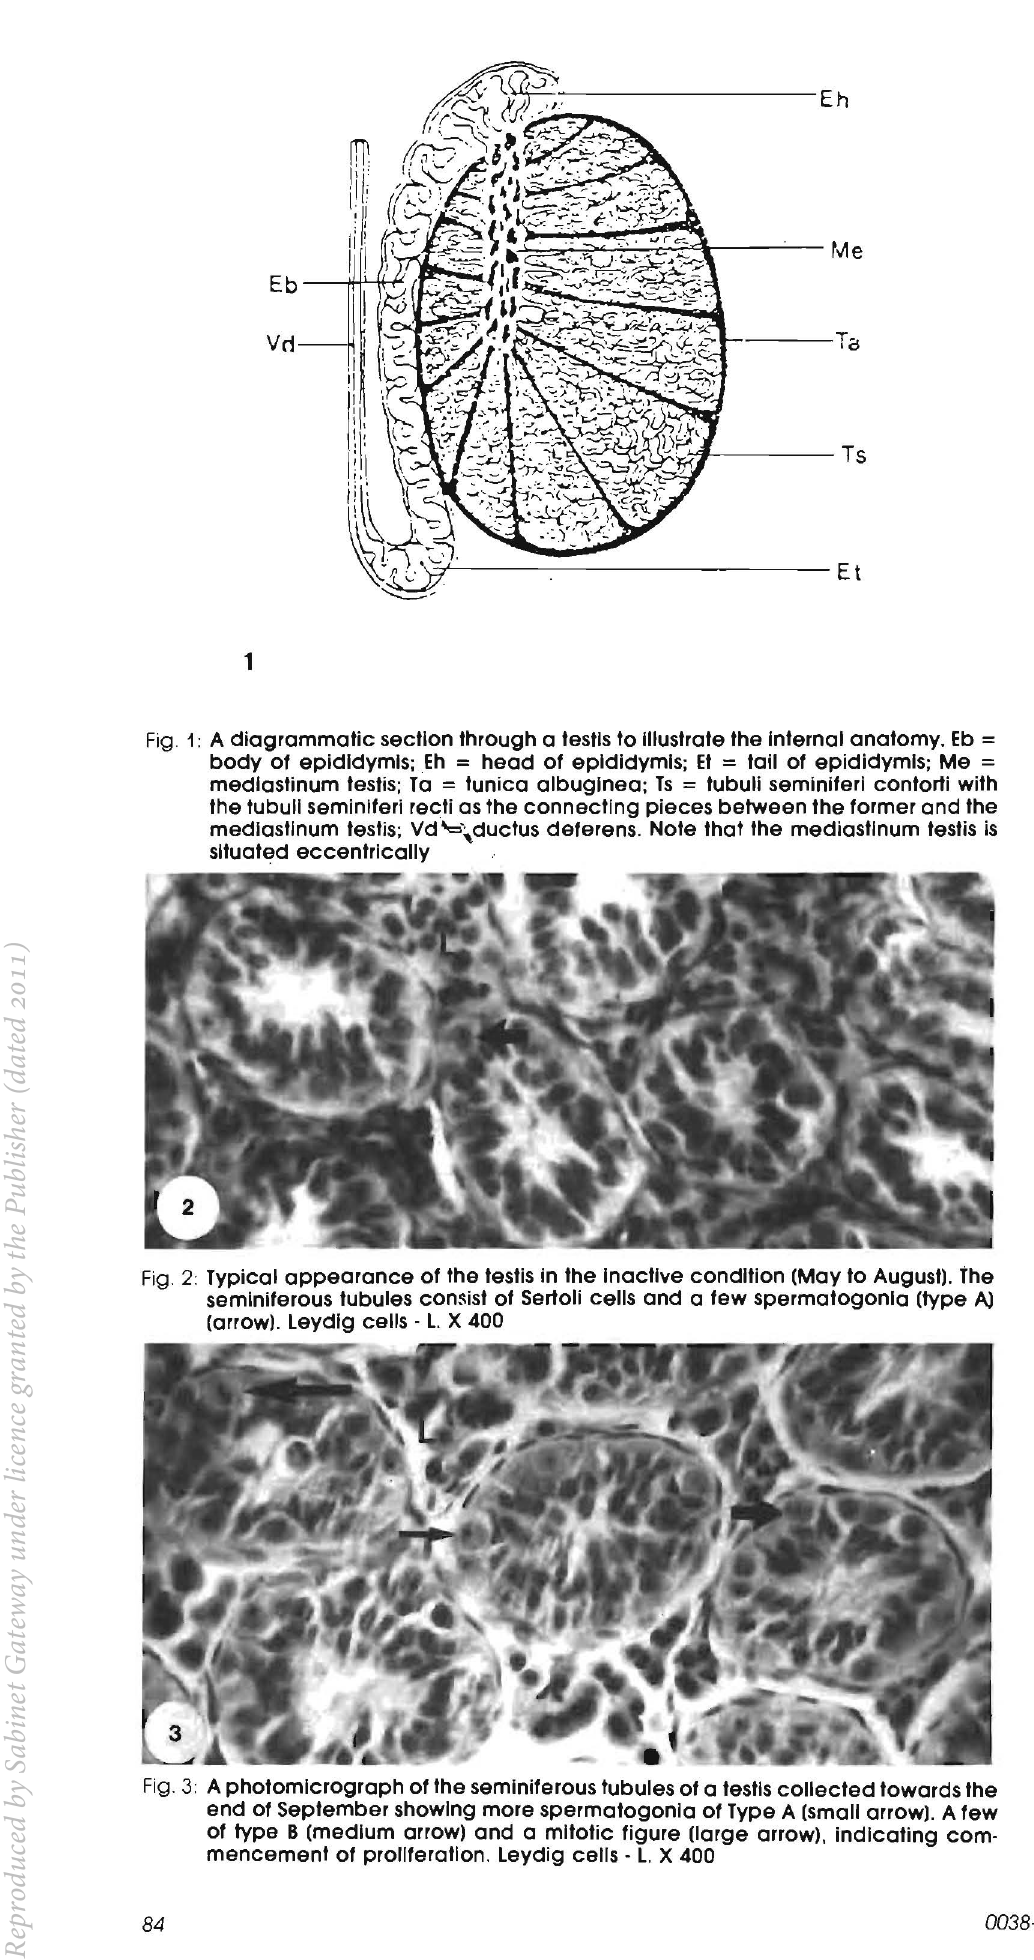
Fig. 3: A photomicrograph of the seminiferous tubules of a testis collected towards the end of September showing more spermatogonia of Type A (small arrow). A few of type B (medium arrow) and a mitotic figure (large arrow). indicating com mencement of proliferation. Leydig cells - L X